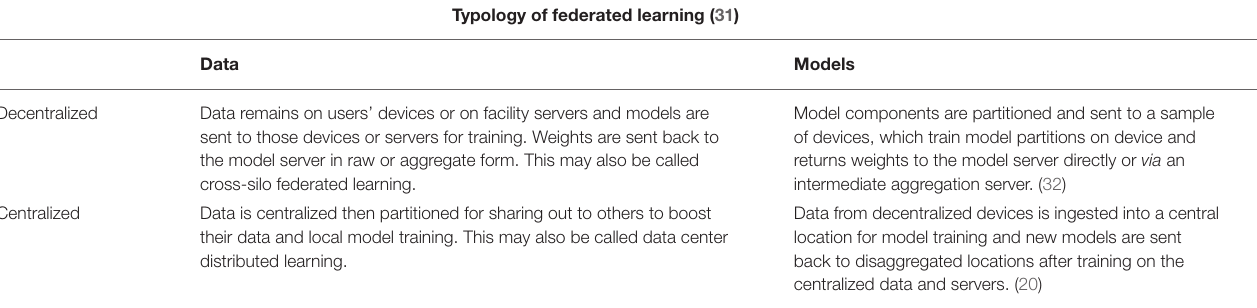
TABLE 2 | Typology of federated